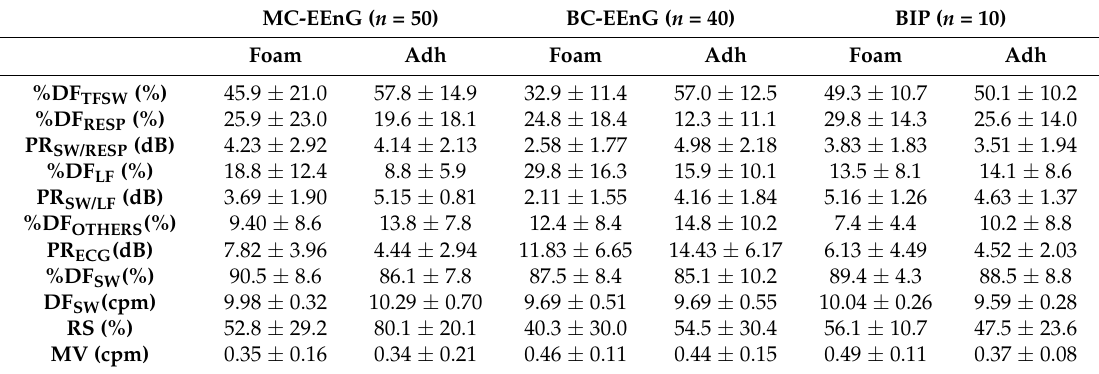
Table 4. Mean and standard deviation of the parameters defined for SW identification and interference quantification of surface abdominal signals picked up with different recording factors. Signals recorded in AN position in 10